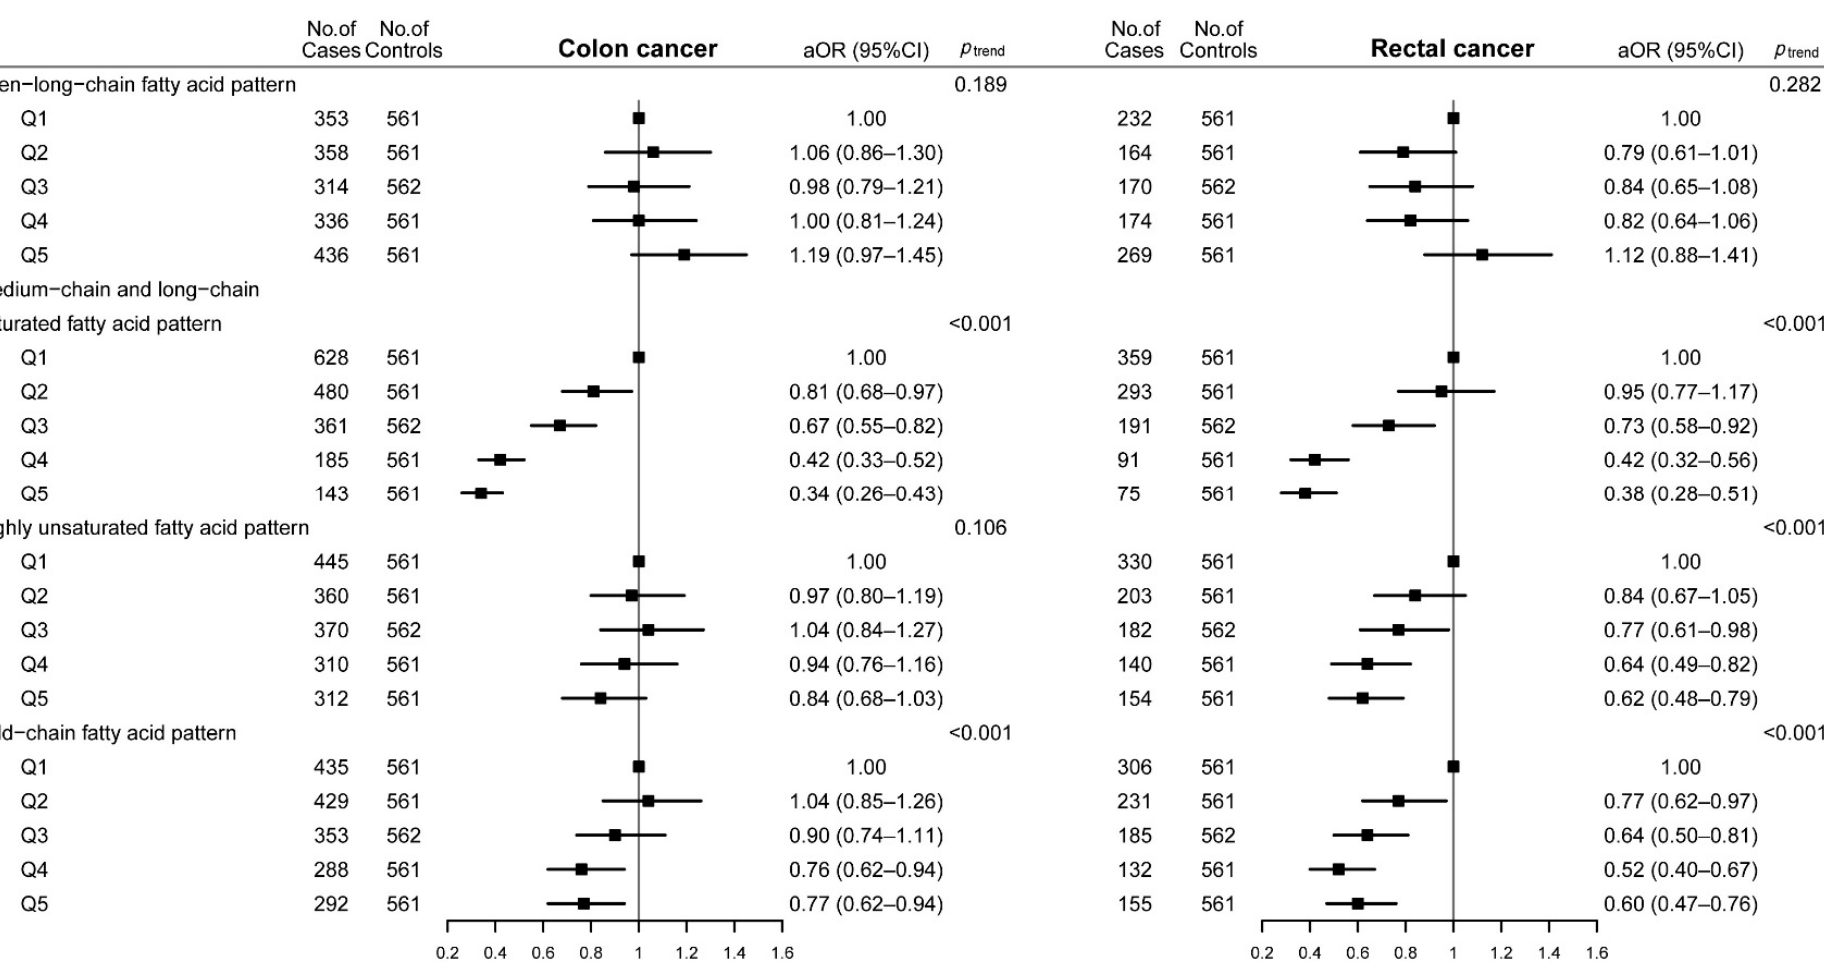
Figure 3. Adjusted odds ratios and 95% confidence intervals of colorectal cancer across quintiles of dietary fatty acid patterns according to cancer site. Abbreviations: Q, quintile; Q1–Q5 means the lowest quintile to the highest quintile. aOR, adjusted odds ratio; CI, confidence interval. Adjusted confounding variables included age (years), marital status, residence, education, occupation, income, occupational activity, MET, BMI, smoking and drinking status, history of cancer in first-degree relatives, and daily intakes of energy, vegetables, and fruits. The value of p for trend was calculated by placing Q1–Q5 as a continuous variable in the regression